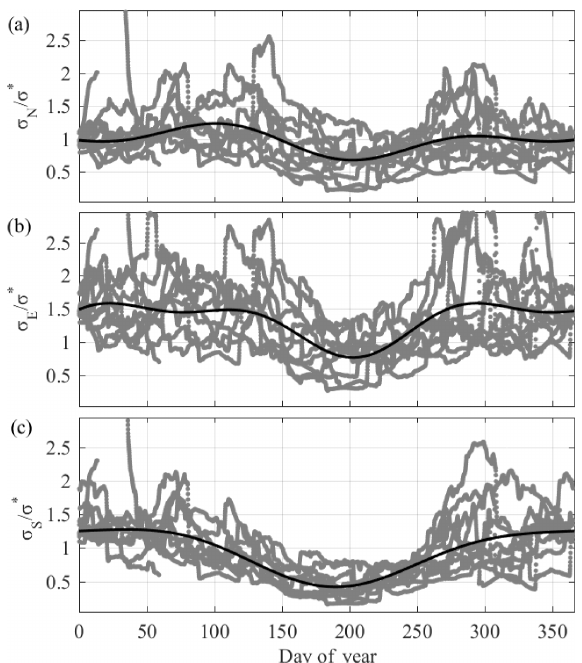
Figure 10. Normalized residuals from this study showing only the seasonal variation (same as Fig. 4), for (a) the northern, (b) the equatorial, and (c) the southern regions. The Fourier fit is shown using the black